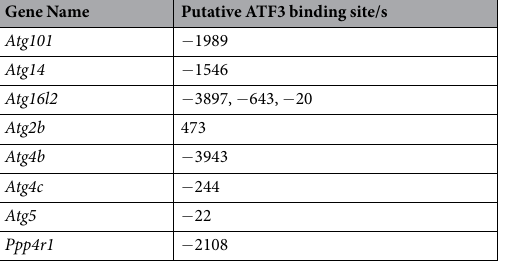
enriched in JEV-infected cells when ATF3 antibody was used for the pull-down (Fig. 6). However, an irrelevant IgG (negative control) failed to pull-down the desired product. Importantly, despite having predicted ATF3 bind- ing site, we did not see an enrichment of Atg101- or Atg14- specific PCR product, suggesting that ATF3 specifically occupied the promoter regions of Atg5 . These data show that ATF3 binds the Atg5 promoter and could control its expression. Indeed, ATF3 was shown to significantly suppress the expression of Atf5 transcripts in Neuro2a and MEF cells (Fig. 7). Accordingly, the level of ATG5 protein was enhanced in ATF3-depleted Neuro2a cells (Fig. 7a). These data clearly show that the autophagy-related gene Atg5 is a direct transcriptional target of ATF3. ATF3 positively regulates JEV replication. Loss of ATF3 led to robust induction of antiviral and auto- phagy pathways, and since both of these have antiviral effects, we investigated the role of ATF3 in JEV replication. To this end, we studied virus replication in ATF3-depleted Neuro2a and MEF cells where a ~60% reduction in